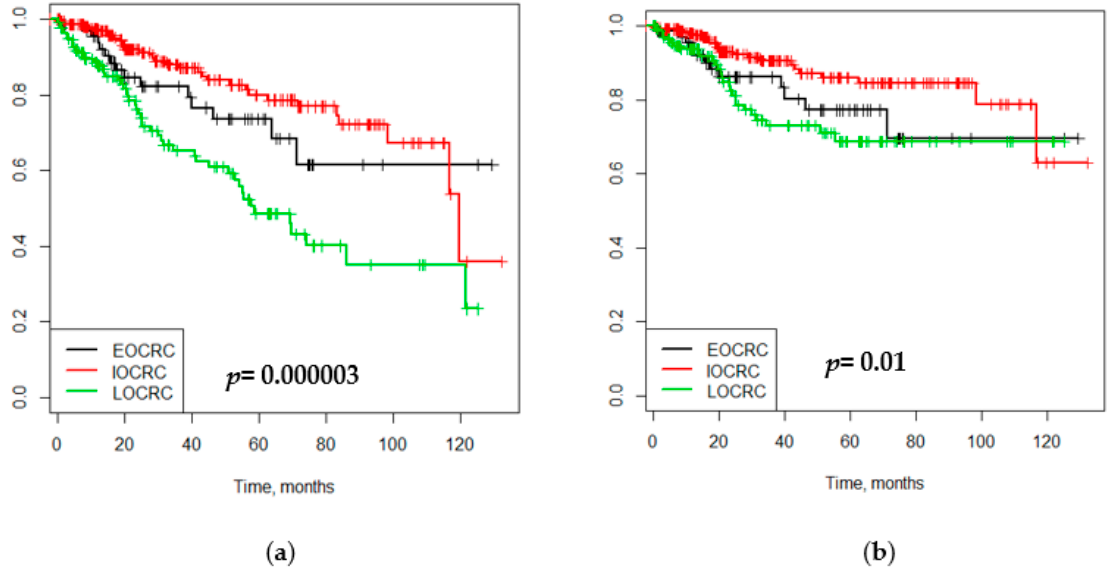
1 Statistical comparison was performed using chi-square ( χ 2) test. MSI: microsatellite instability. FAP: Familial Adenomatous Polyposis. NS: not significant. Figure 3. Survival analysis. ( a ) Overall survival by age of onset; ( b ) cancer-specific survival by age of onset. Five- and ten-year survival analysis showed that EOCRC patients have better survival to ten years or more after CRC diagnosis, with 61.5% in OS (95% CI 45.2–83.7) and 69.4%